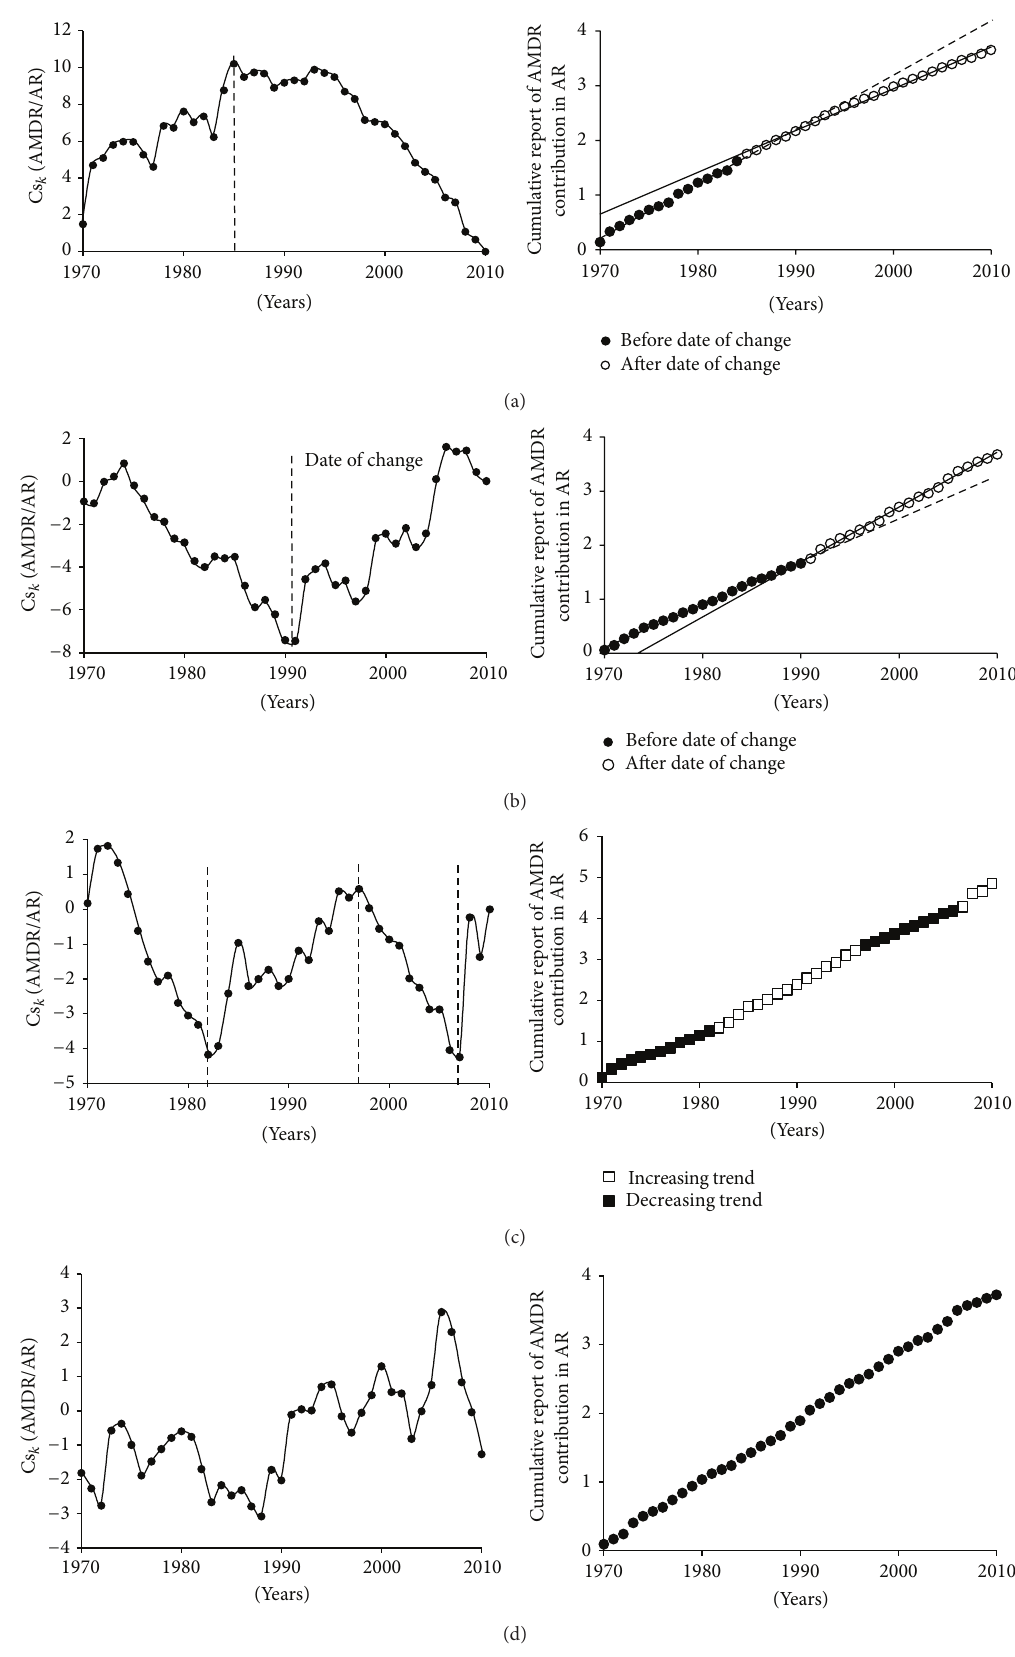
Figure 6: Buishand and double mass methods applied to AMDR contribution to